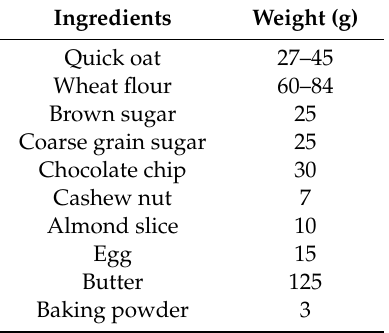
Table 5. Ingredients used in cookie dough preparation.